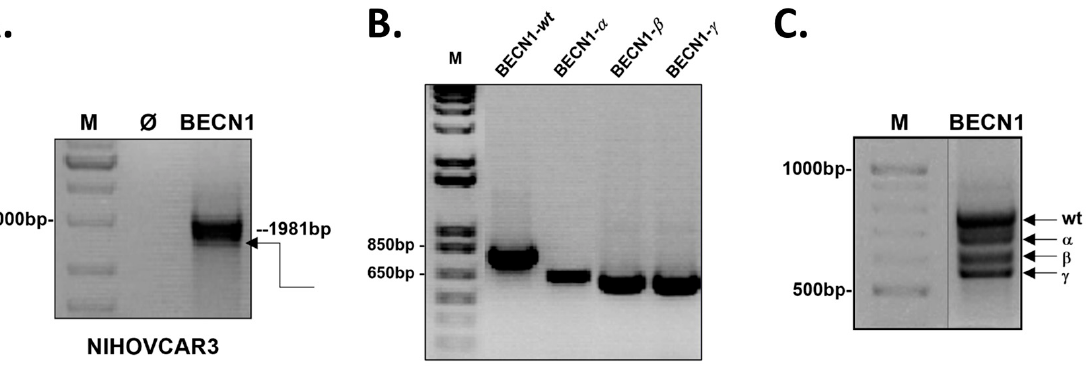
Figure 1. Isolation of BECN1 transcript variants from ovarian cancer cells NIHOVCAR3. Agarose gel electrophoresis of the products of ( A ) the RT-PCR, ( B ) screening PCR, and ( C ) nested PCR. Expected bands for the wild-type BECN1 isoform are indicated (( A , B ), dotted lines). Arrow in ( A ) indicates putative additional RT-PCR product. Arrows in ( C ) indicate the wild-type BECN1 (wt) and the short BECN1 isoforms α , β , and γ . Molecular weight standard, M. Negative control (no template),